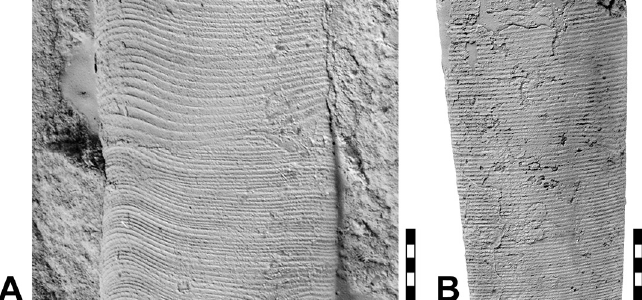
Fig. 6. Shell injuries of lituitid specimens (shown in the centre to the right in both A and B). A . Lituites bottkei sp. nov., holotype MB.C.29651 (Bottke Coll.) from Gärdslösa (Island of Öland, Sweden). of Öland). Scale bar units = 1